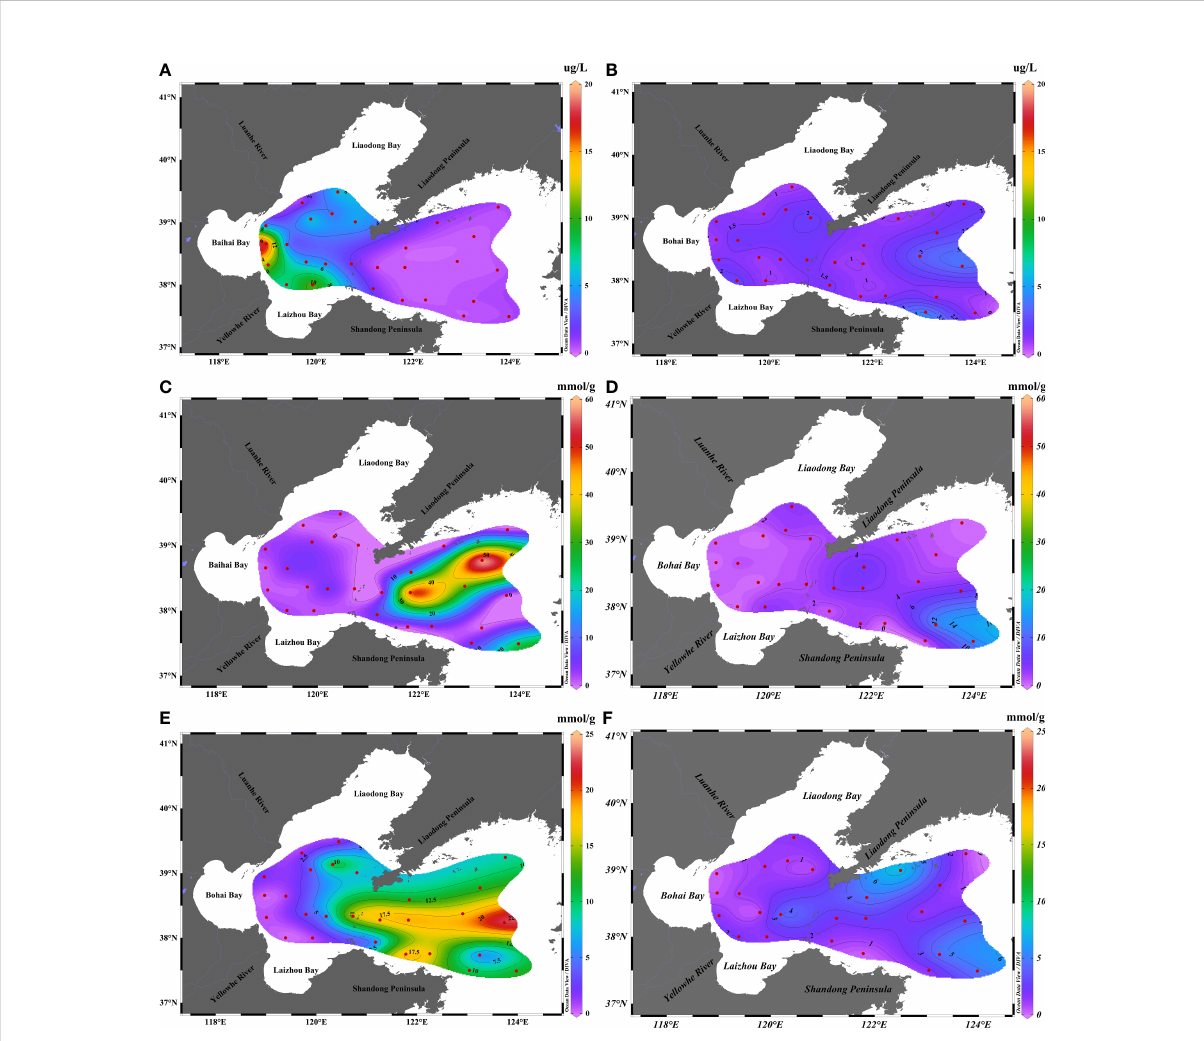
FIGURE 9 Concentrationof Chl-a and ratios ofDMS/Chl-a and DMSPp/Chl-a in the surfacewatersofBSand NYS in summerand autumn. Chl-a concentration in (A) summer and (B) autumn. DMS/Chl-a ratio in (C) summer and (D) autumn. DMSPp/Chl-a ratio in (E) summer and (F)